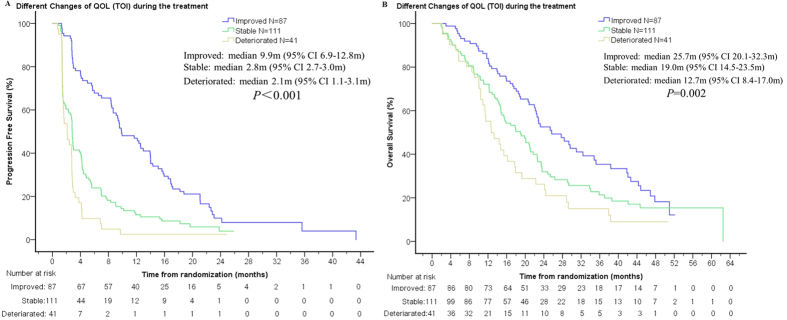
The relationship between QoL change (assessed by TOI score) during treatment and prognosis(A: PFS; B: OS). Patients with an improvement in QoL had significantly longer PFS and OS compared with patients with stable or worsened QoL.